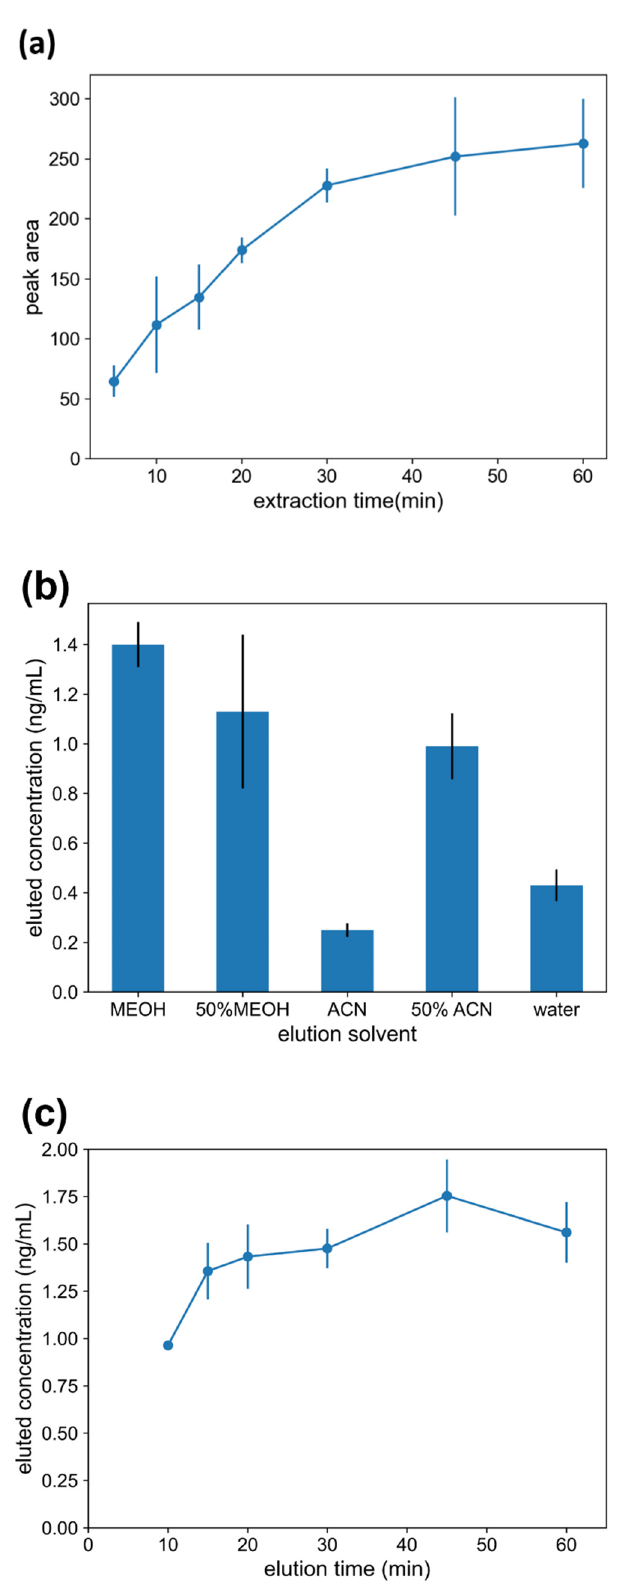
Figure 4. Optimization of SPME method using GO-PAN@PNE fibers in spiked fish samples: ( a ) extraction time; ( b ) elution solvent; ( c ) elution time.